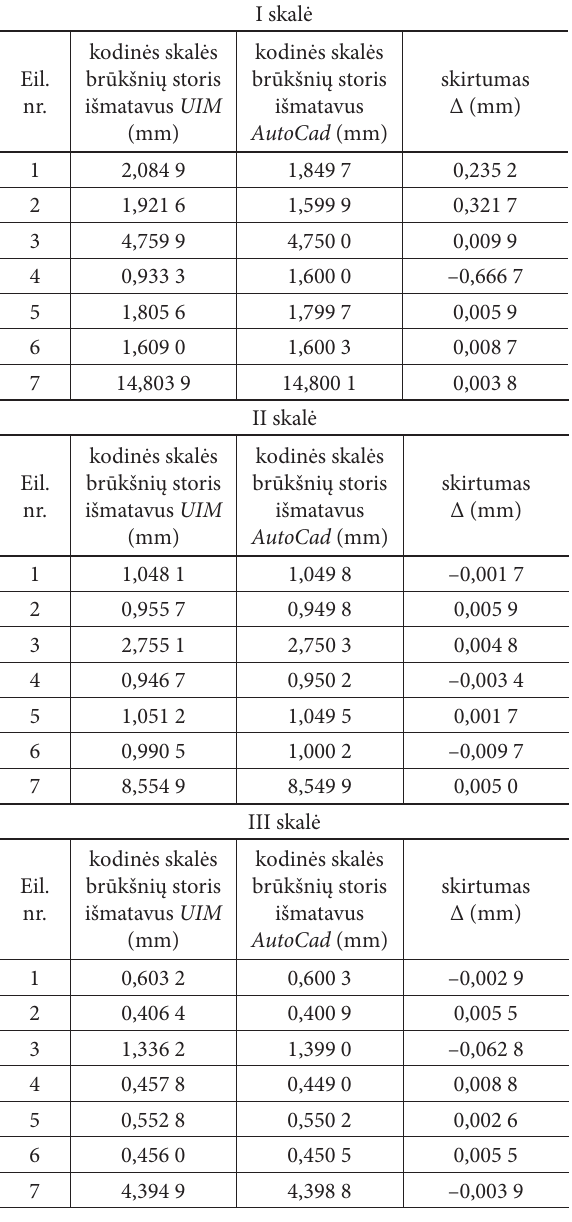
Table 2 . Coded scale thickness of the lines measured using a microscope in the AutoCAD